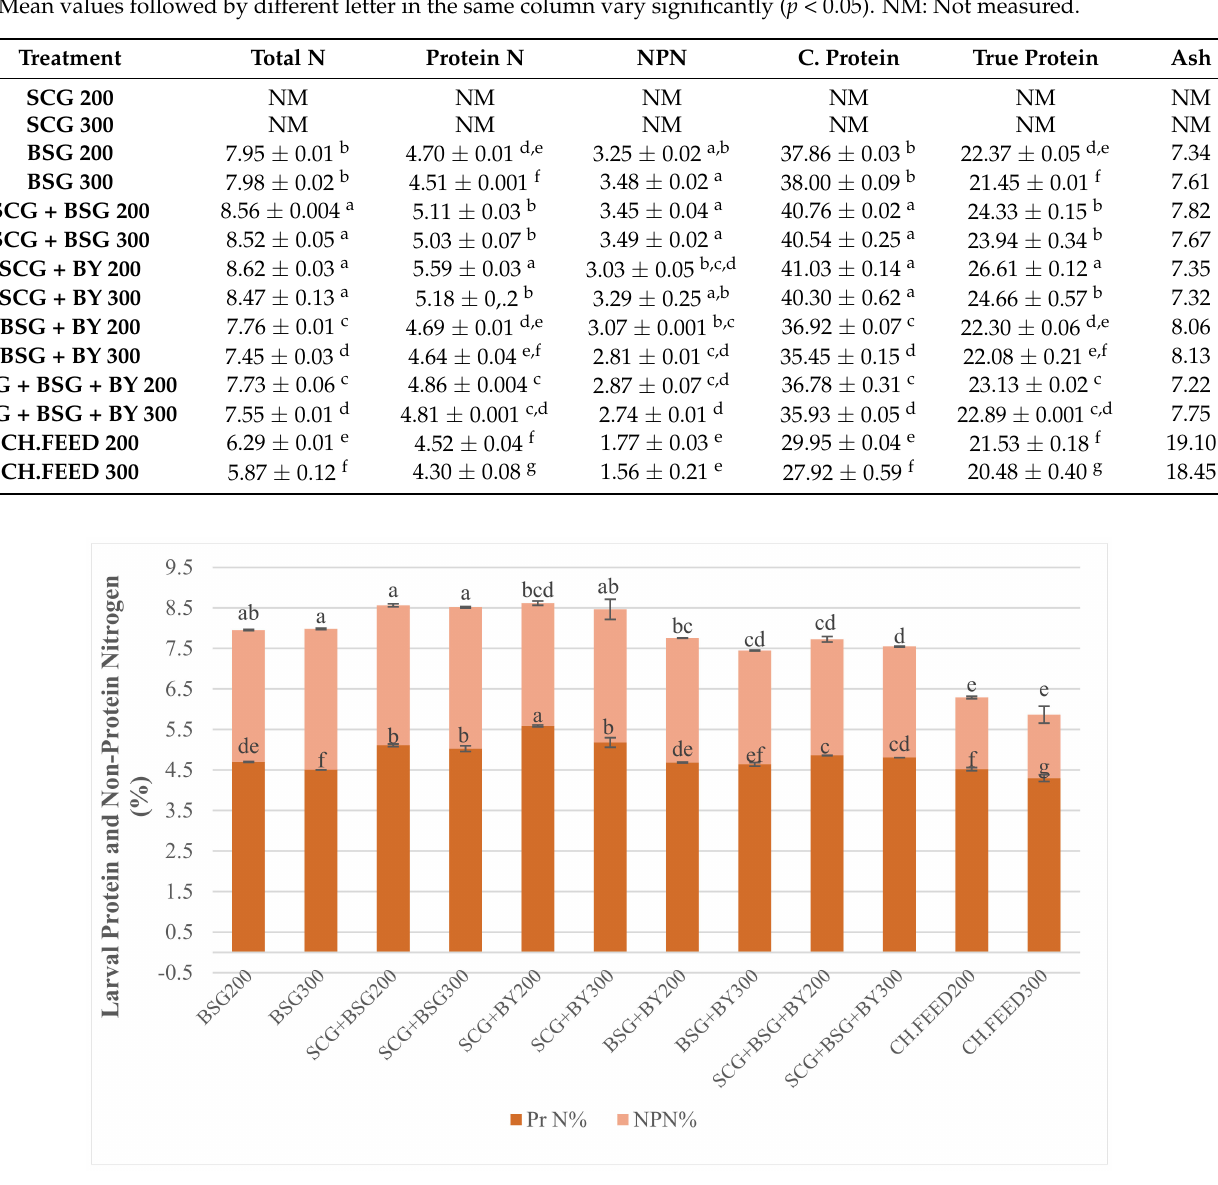
Figure 2. Effect of treatment, i.e., interaction between feed and density, on larval protein and non-protein nitrogen out of total nitrogen (% of DM), (mean ± standard error, n = 4). Mean values followed by different letter in the same level vary significantly ( p <